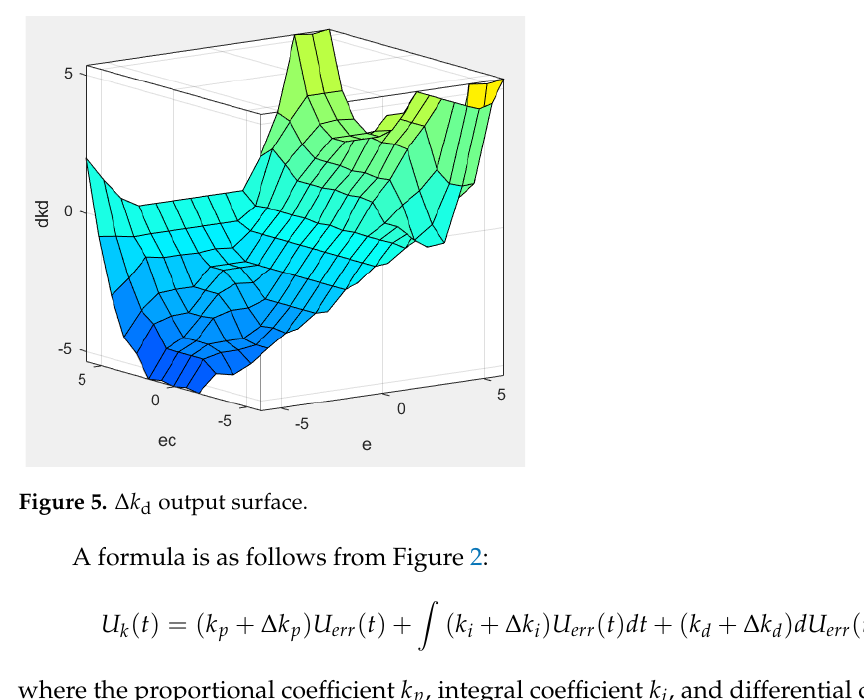
k  output surface. i